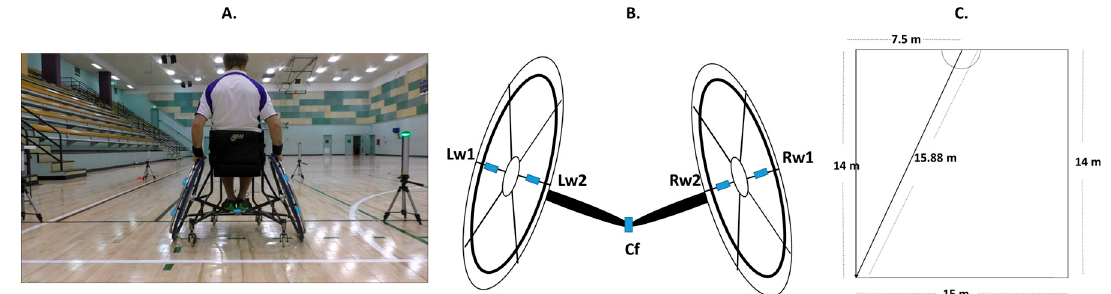
Figure 2. IMU sensor placement. Right wheel 1 and 2 (RW1 + RW2) and Left wheel 1 and 2 (LW1 + LW2) oriented +x wheel rotation direction and +z into the wheel. Centered frame (Cf) sensor oriented +x forward, +y right, +z down. ( A ) photo of sensor placement, with blue squares overlaid on sensors to increase visual prominence; ( B ) schematic of the sensor location with additional componentry removed; and ( C ) court testing dimensions.